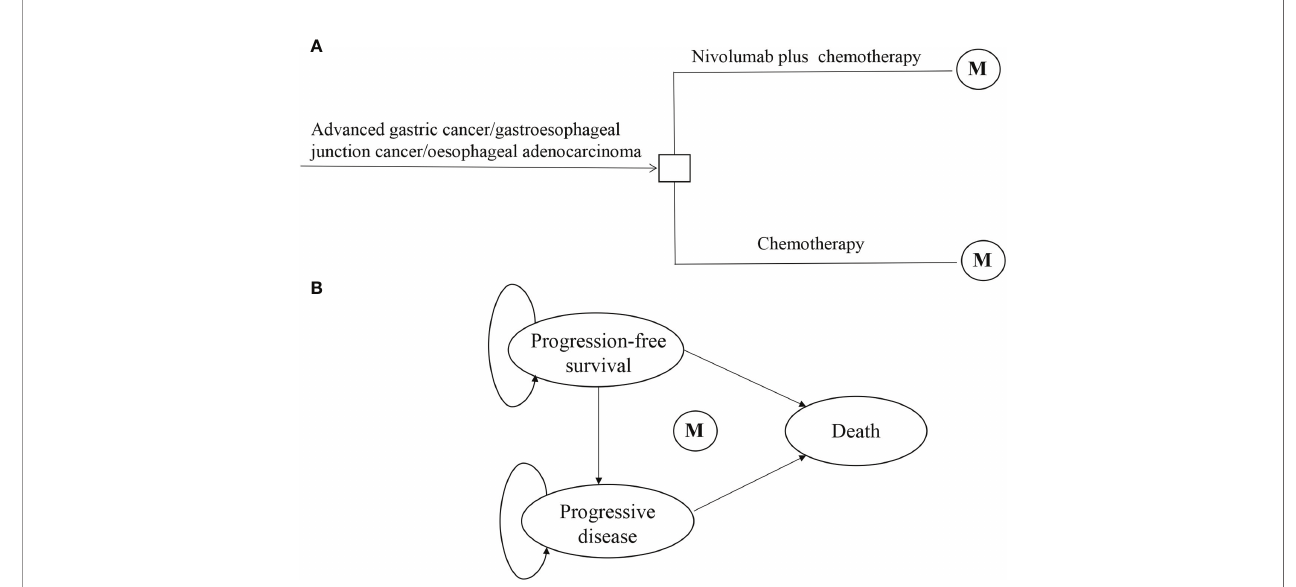
FIGURE 1 | Model structure of a decision tree combining the Markov state transition model with the 3 health states. (A) Decision tree. (B) Markov state transition model. M, Markov node.